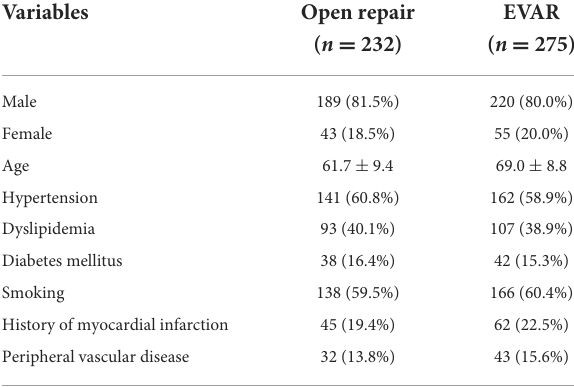
TABLE 2 Demographics and comorbidities of patients undergoing open repair or EVAR for AAA during 2004–2019 in young and middle-aged group.